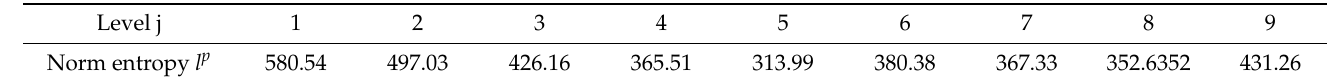
Table 6. Norm entropy l p in different decomposition with db5 wavelet.